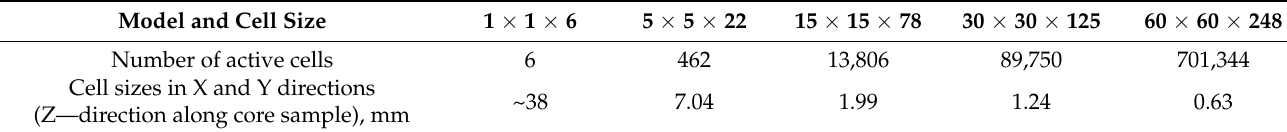
Table 4. Final model parameters.